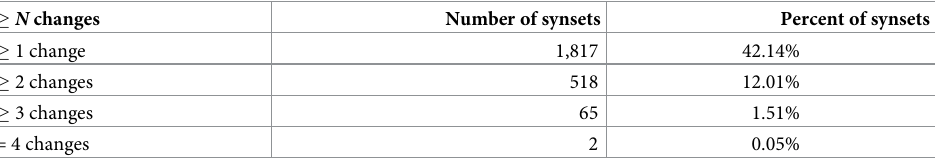
Table 3. The frequency of synset leadership changes over 200 years, given a fifty-year cycle of eleven-year samples. Change of leadership is common. � N